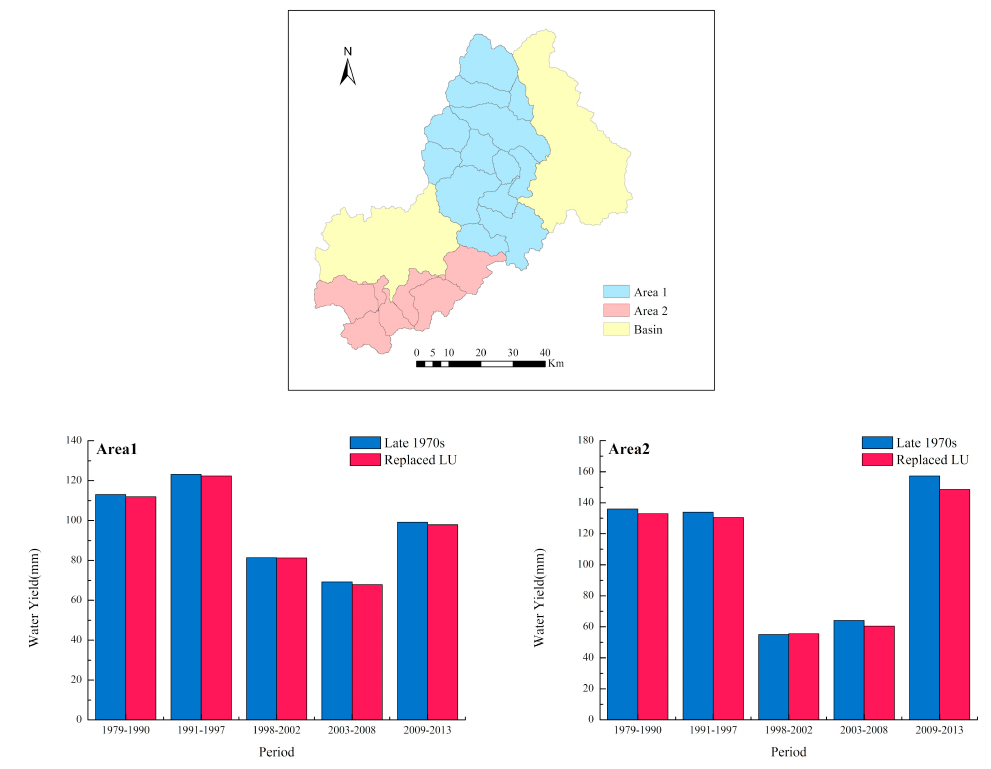
Figure 14. Selected areas and their water yield change.